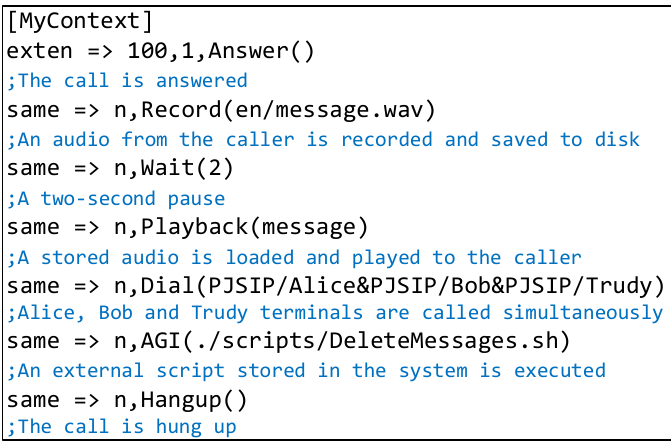
Figure 1. Asterisk dial plan